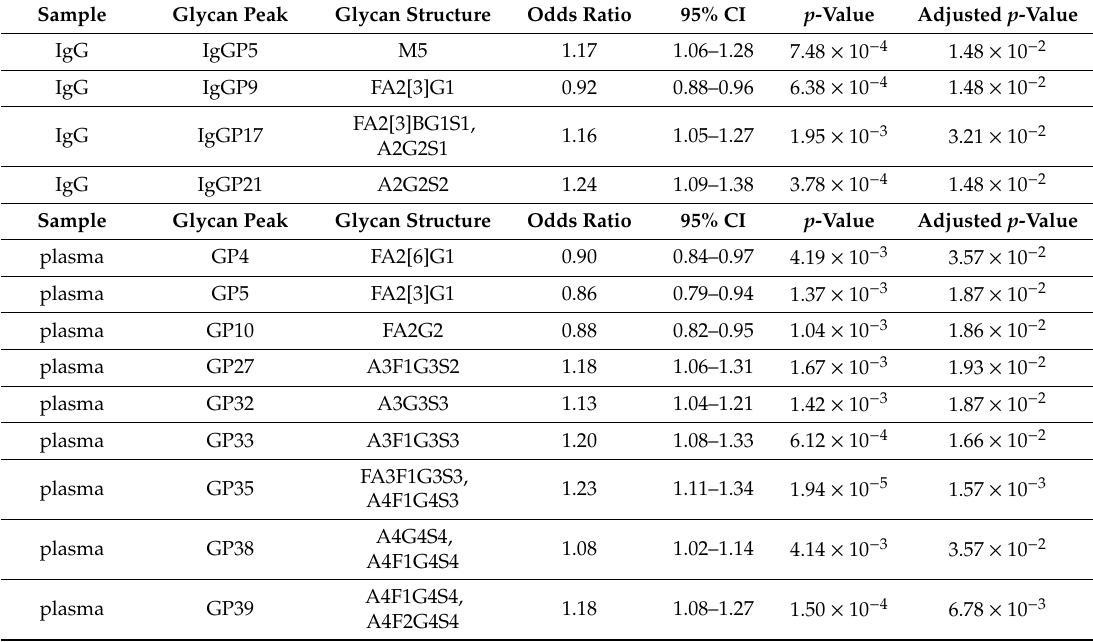
Table 2. Comparison of IgG and plasma protein initial glycan traits between subjects with MS and matched controls.